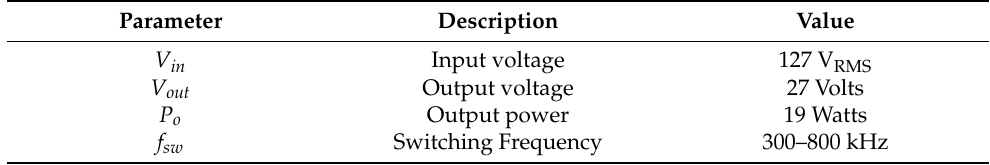
Table 1. Design parameters for experimental tests.